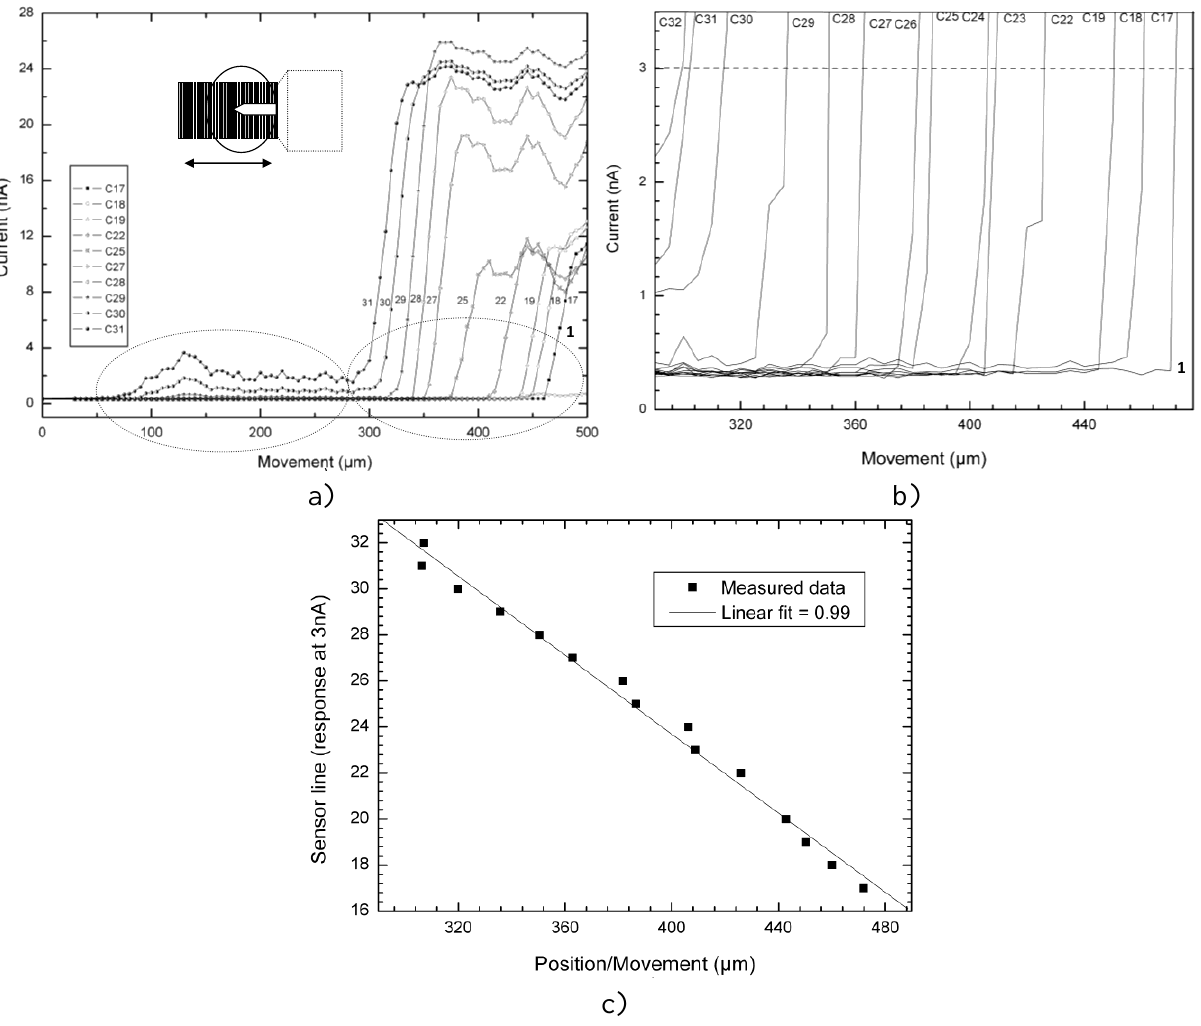
perpendicular to the sensor lines (b) Sketch of the response of each detector at the 3 nA threshold level, when just the holding structure of the cantilever is present (c) Sketch of the measured data at each detector for the 3 nA threshold level and its related linear